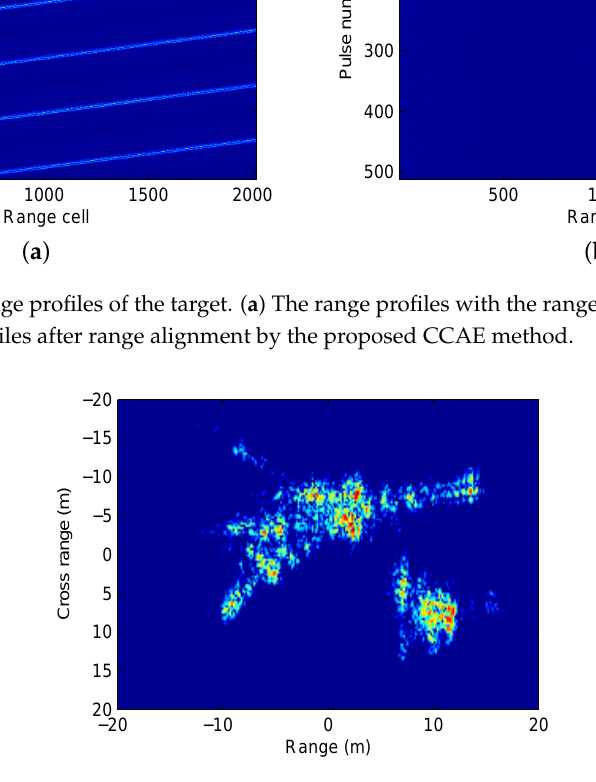
Figure 13. The result of inverse synthetic aperture radar (ISAR) imaging after range